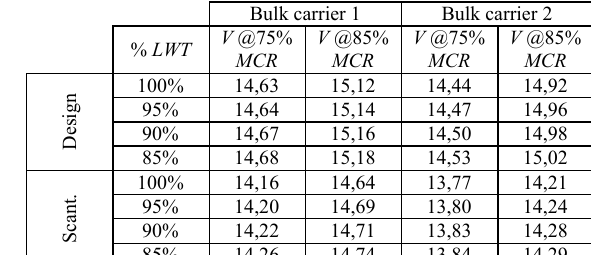
Figure 5. Attained and required EEDI / EEXI